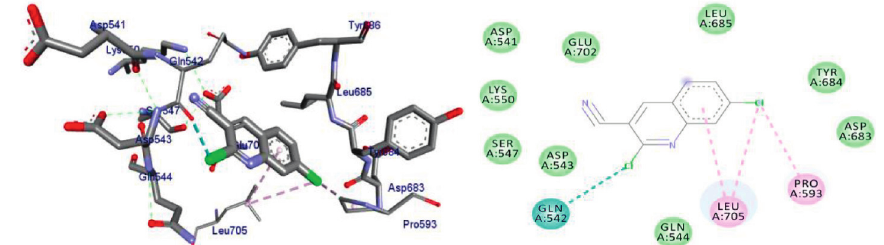
Figure 7: The binding interactions of compound 5 against human topoisomerase II α (PDB ID: 4fm9).